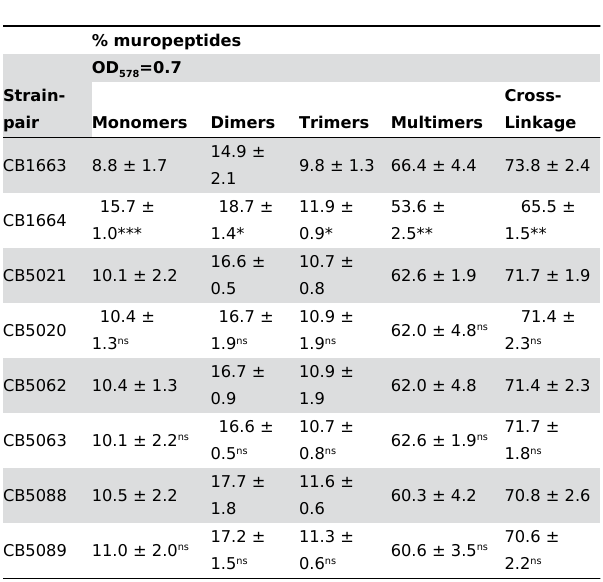
Table 4. Distribution of muropeptides and amount of